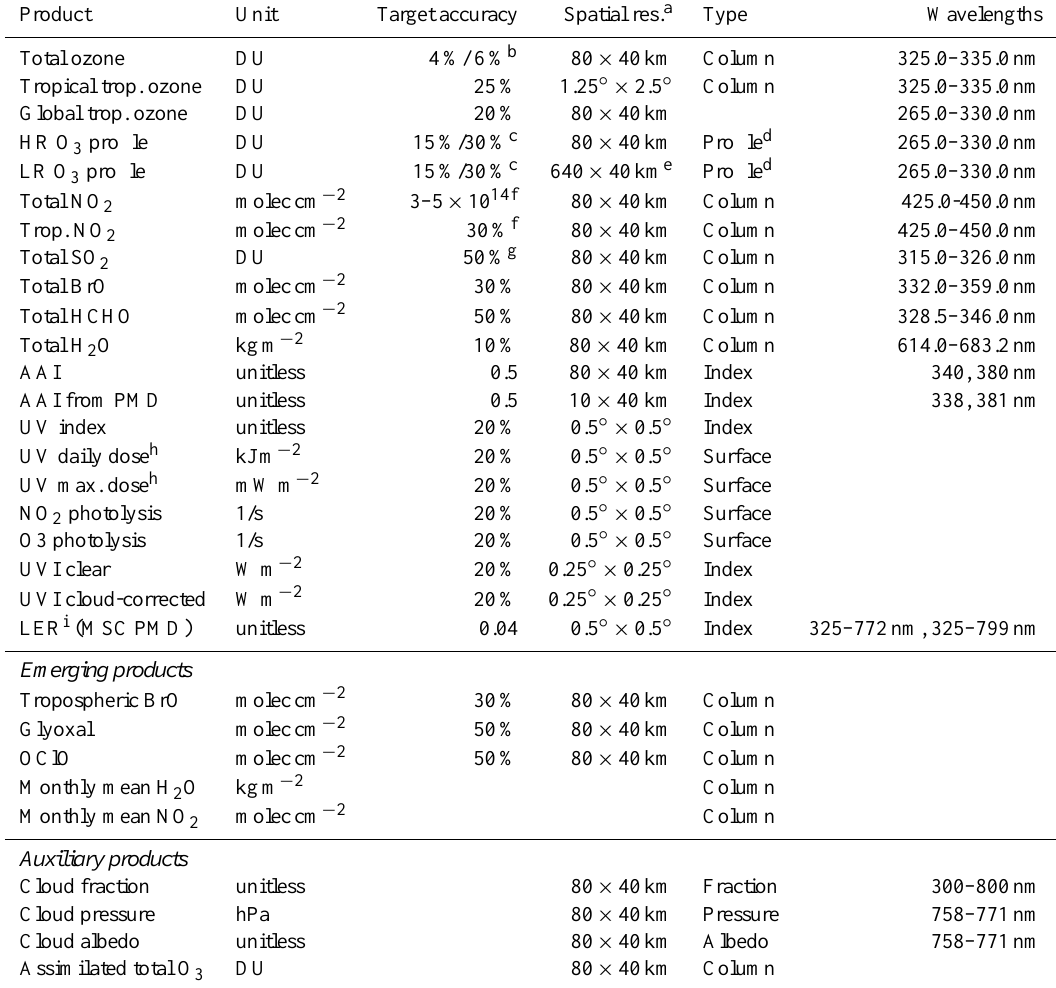
Table 1. O3M SAF GOME-2 L2 products available to users, a summary table showing physical properties. HR O 3 profile refers to high spatial resolution a ozone profile product whereas LR O 3 profile refers to low spatial resolution a ozone profile